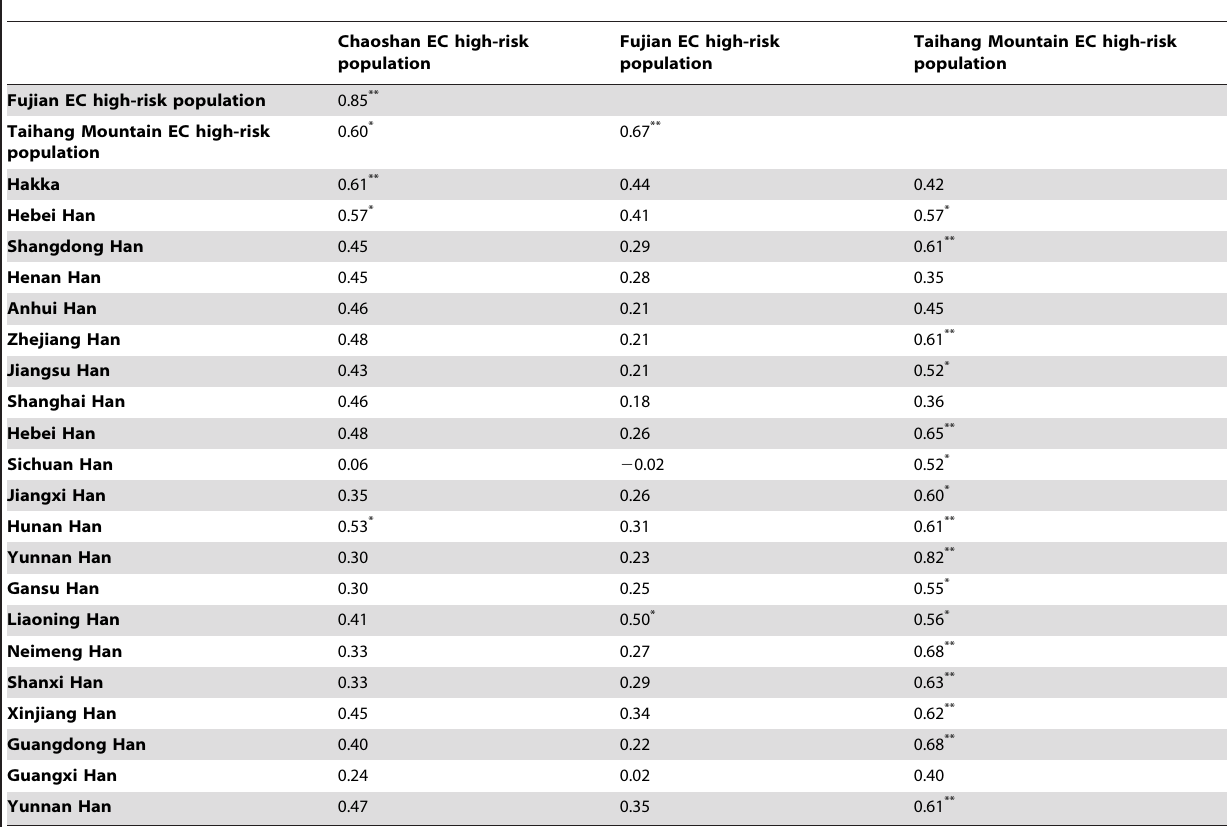
Table 2. Correlation analysis of Y-SNP haplogroup frequencies of the 3 EC high-risk populations and 20 Chinese Han